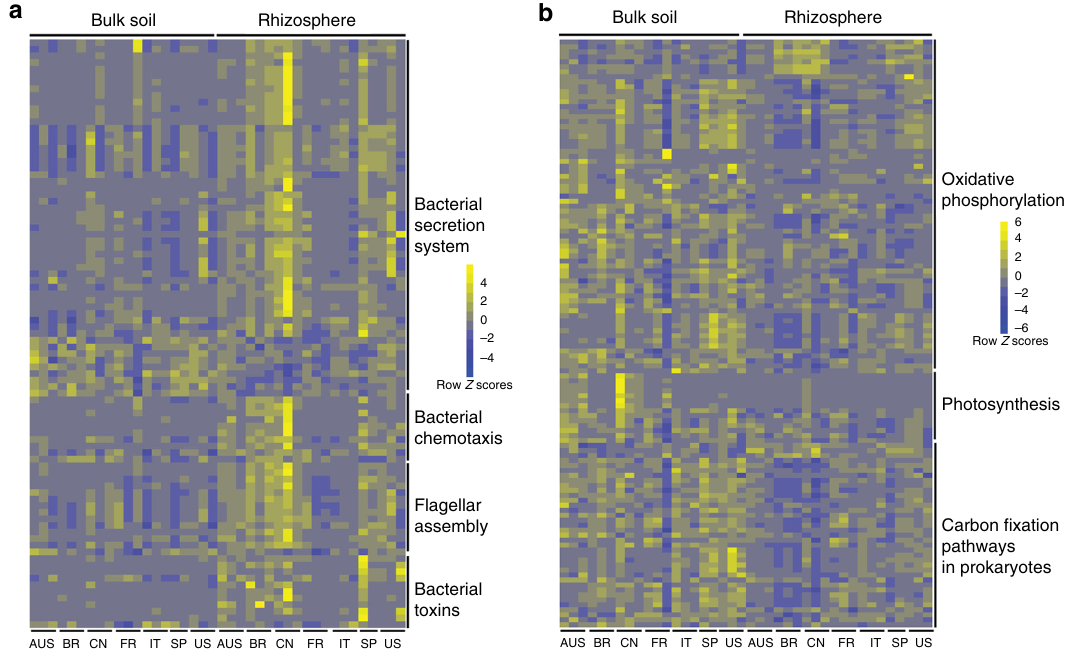
Fig. 5 Relative abundances of core and universally depleted KOs in the rhizosphere microbiome. a Relative abundances of core rhizosphere KOs involved in microbe – host interaction-related pathways across locations and compartments. b Relative abundances of universal rhizosphere-depleted KOs involved in energy metabolism across locations and compartments. Scale, relative abundance of genus at row normalization by removing the mean (centering) and dividing by the standard deviation (scaling). The color from blue to yellow represents a relative abundance of each taxa from low to high. AUS Australia, BR Brazil, CN China, FR French Réunion island, IT Italy, SP